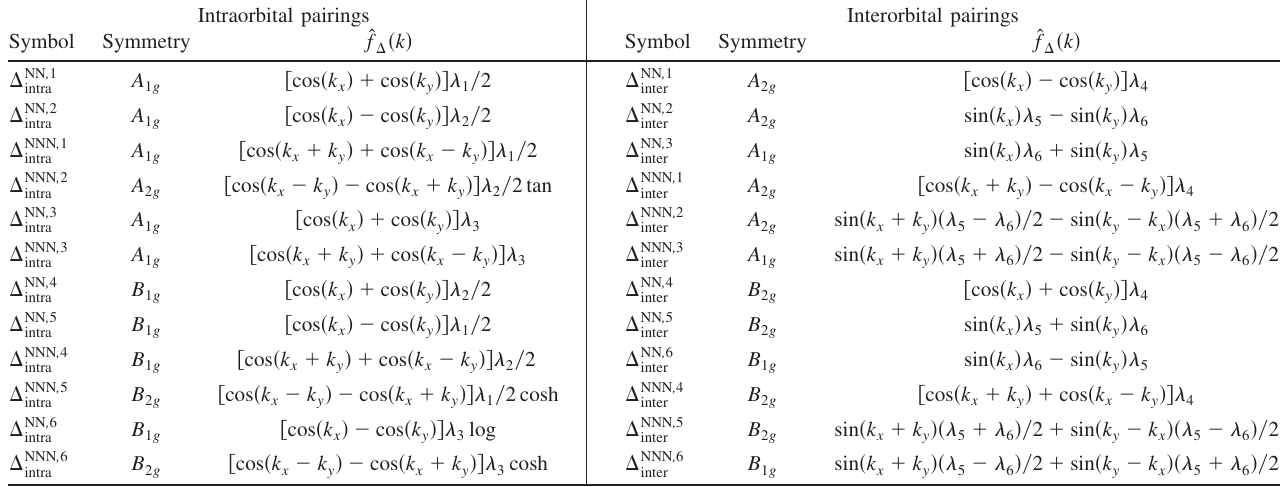
TABLE I. Definitions of superconducting order parameters and their corresponding irreducible representations and functional forms in momentum